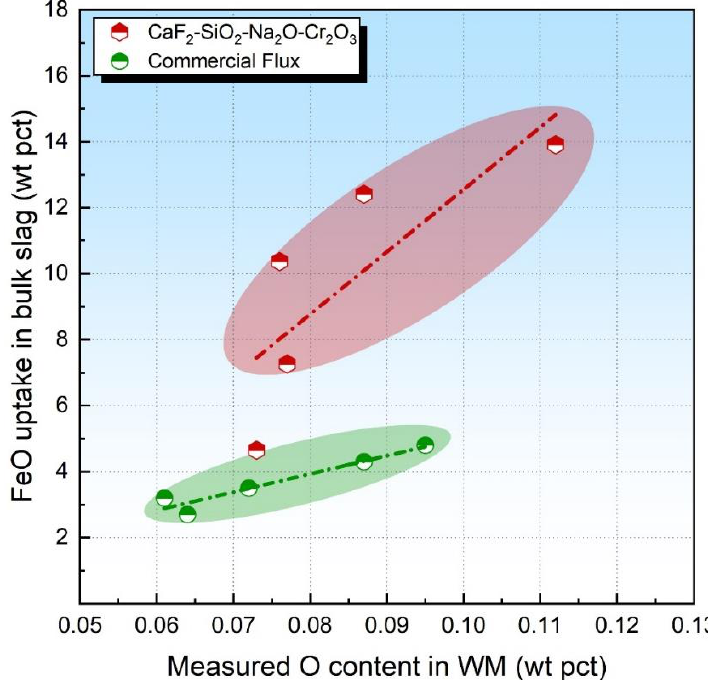
Figure 4. FeO content in bulk slag as a function of measured O content in WM.